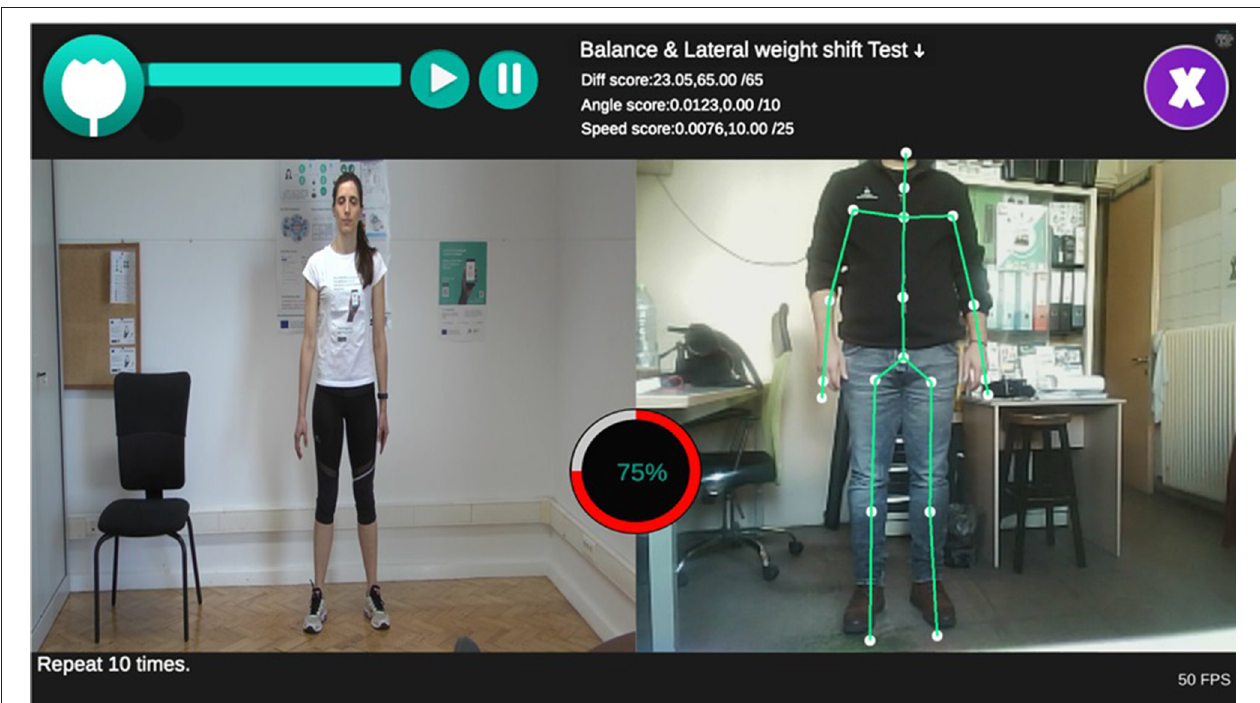
FIGURE 2 | User Interface of the Assessment Test 1(Balance and Walking) of the iPrognosis Games. The user’s performance (on the right side) and the expert’s performance (on the left side), so the players easily synchronize their movement along with the expert’s movement. The general score of the user (75%) (represented by red circle on the center of the panel) is displayed in real-time, as well as intermediate metrics (i.e., Diff score, Angle score and Speed score) (on the top). The MentorAge ® tracking system sensor allows to display the skeleton of the user and corresponding joints (right panel). [ Permission and consent have been obtained from the first author to appear on the image (on the left) ].